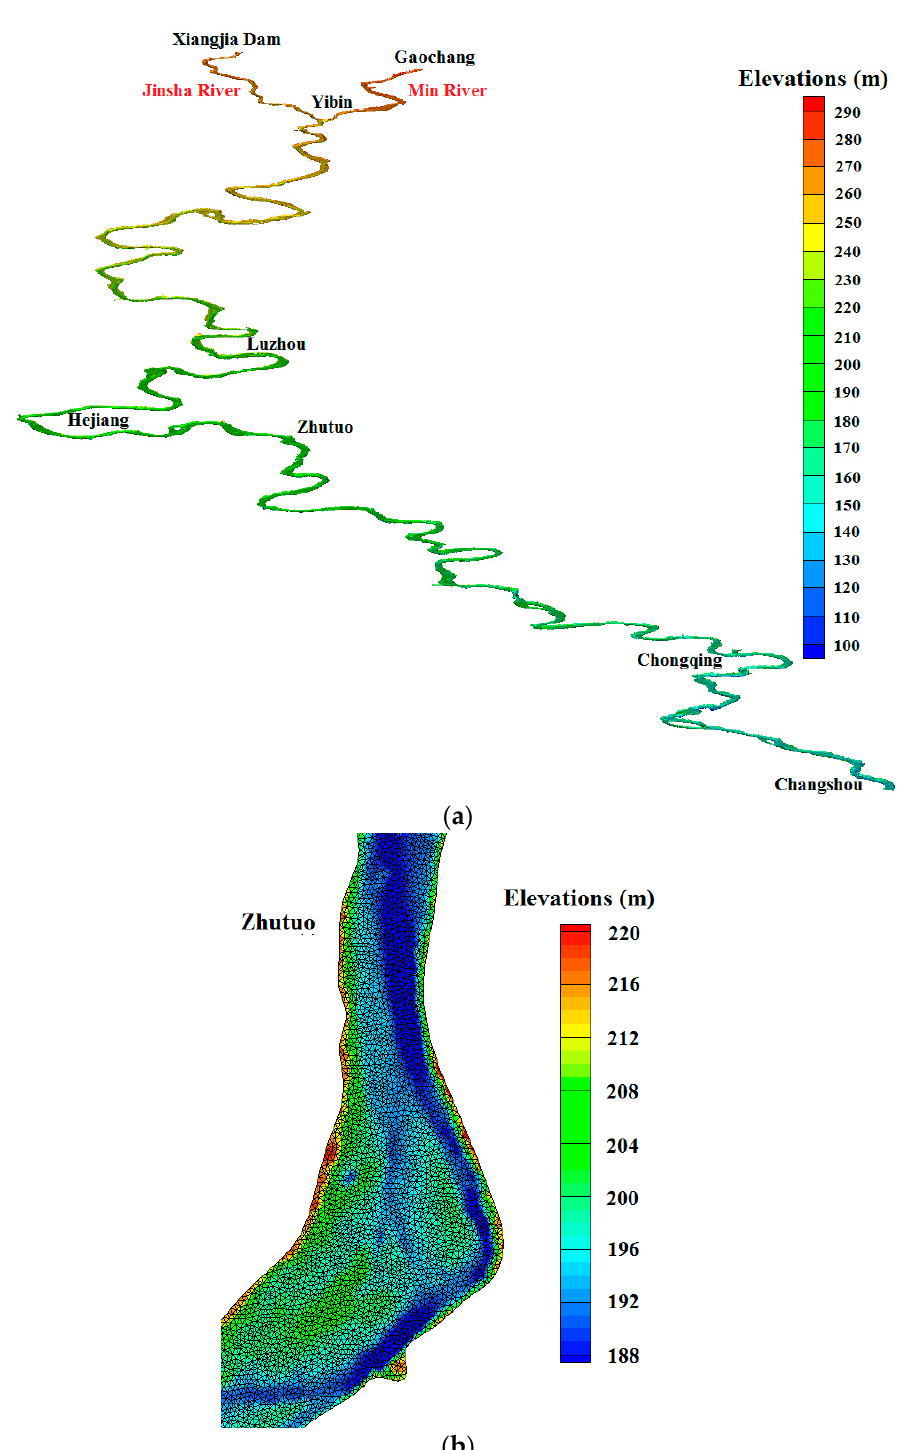
Figure 2. ( a ) Topographic map of computational area; and ( b ) mesh distributions of Zhutuo gauging station.